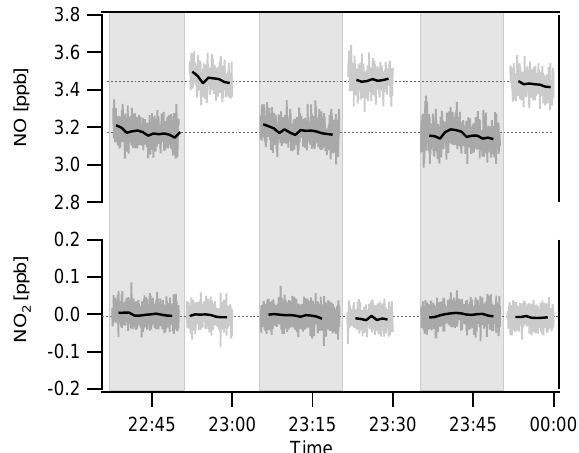
Fig. 7. NO and NO 2 mixing ratios measured with the QCLAS when switching between the two gold converters measuring NO standard gas diluted with “zero” air. The gray areas correspond to the mea- surements of the converter used by the NABEL monitoring instru-